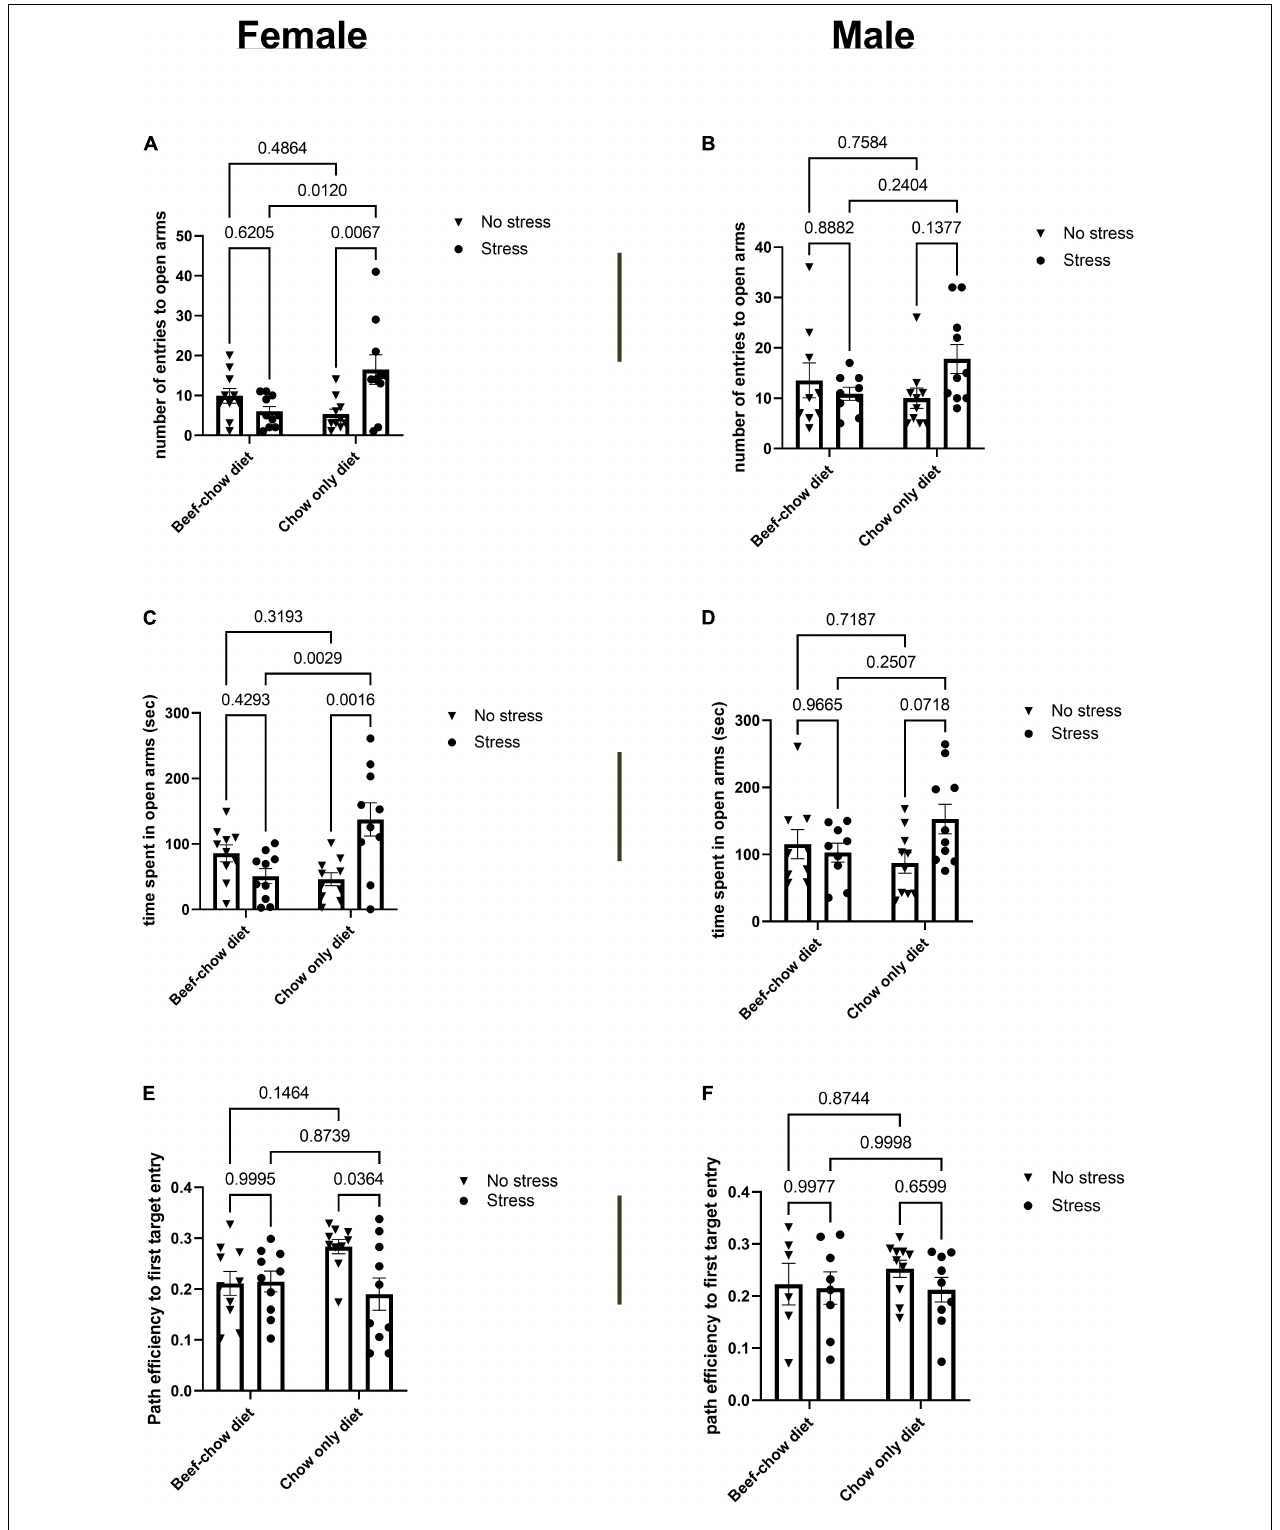
FIGURE 3 | Behavioral outcomes following chronic alternating stressors are sex- and diet- dependent. Number of entries to open arms in the elevated plus maze for female (A) and male mice (B) . Time spent in open arms of elevated plus maze for female (C) and male (D) mice. Long term memory path efficiency to first target entry for female (E) and male (F) mice. Individual values displayed on each bar graph comparison are p -values. Data was analyzed using two-way ANOVA followed by Tukey’s post-hoc test as described in section “Materials and Methods.” Stress encompassed a chronic alternating forced swim and restraint stress paradigm as described in section “Materials and